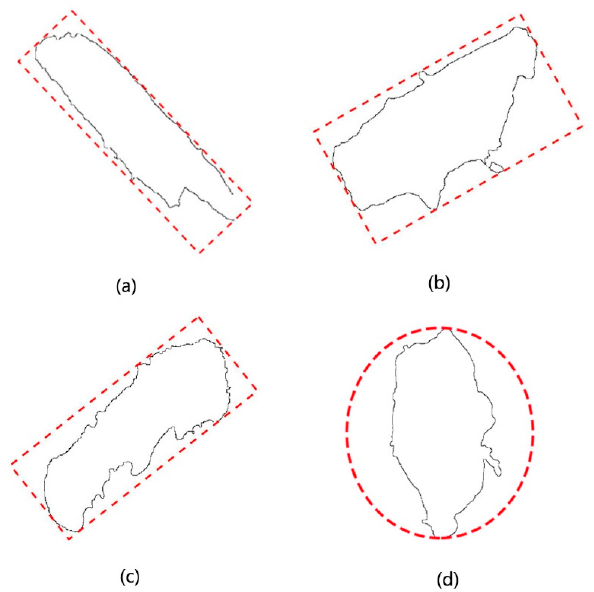
Figure 9. External geometry of Four sorts of wood powder particles: ( a ) Circumscribed rectangle 1; ( b ) Circumscribed rectangle 2; ( c ) Circumscribed rectangle 3; ( d ) Circumscribed circle 4.